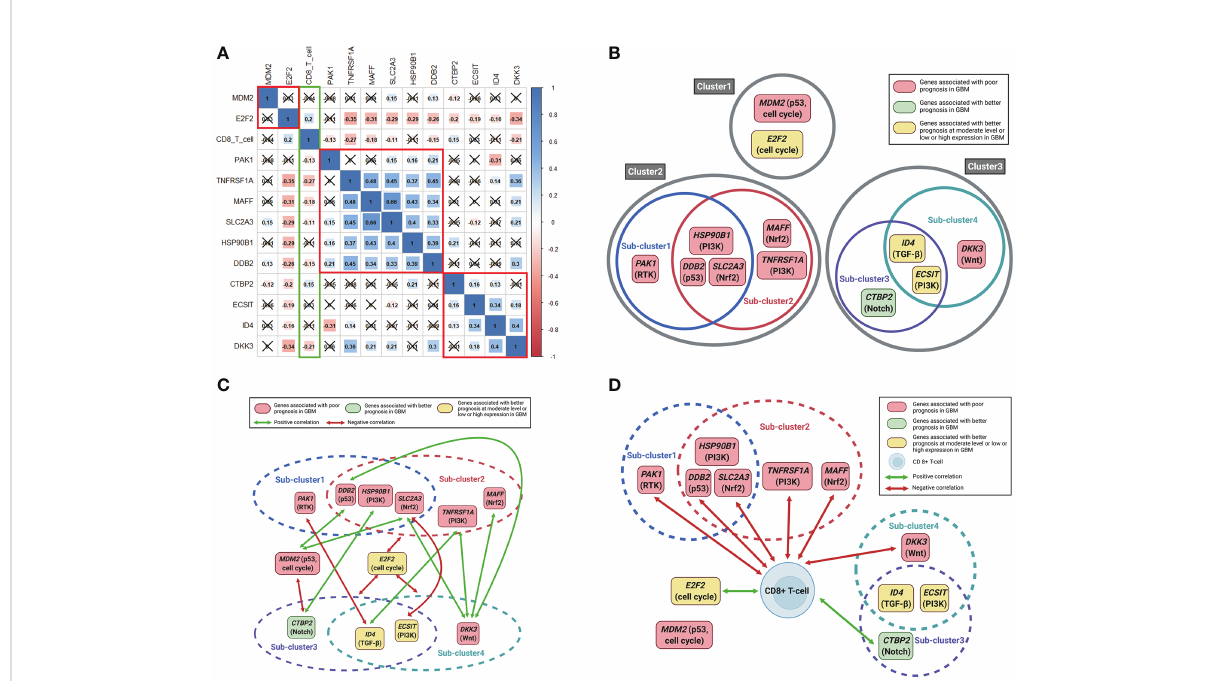
FIGURE 3 Correlation plots between 12 signi fi cant genes and between 12 signi fi cant genes and CD8+ T-cell fractions. Schematic illustrations of correlations between the 12 signi fi cant genes and between the 12 signi fi cant genes and CD8+ T-cell fractions. (A) Pearson correlation coef fi cients and signi fi cance levels were calculated between the 12 signi fi cant genes and between the 12 signi fi cant genes and CD8+ T-cell fractions. The color-coordinated legend indicates the value and sign of Pearson ’ s correlation coef fi cient. The number in the box indicates Pearson ’ s correlation coef fi cient. Moreover, an x in the box indicates a p value ≥ 0.001; (B) the 12 signi fi cant genes are largely classi fi ed into three clusters according to the signi fi cance of the correlation between mutual genes. Clusters 2 and 3 were again divided into two sub-clusters; (C) correlations between gene expression outside the clusters or subclusters; (D) correlations between the expression of the 12 signi fi cant genes and CD8+ T cell